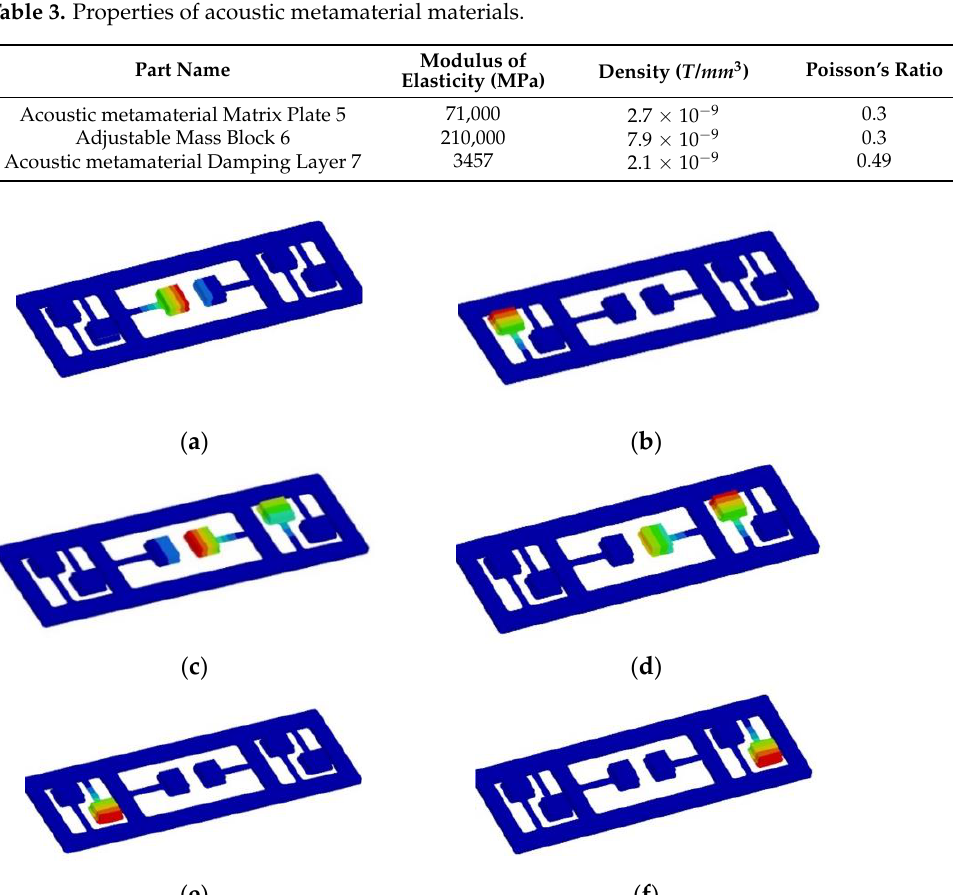
Table 3. Properties of acoustic metamaterial materials.